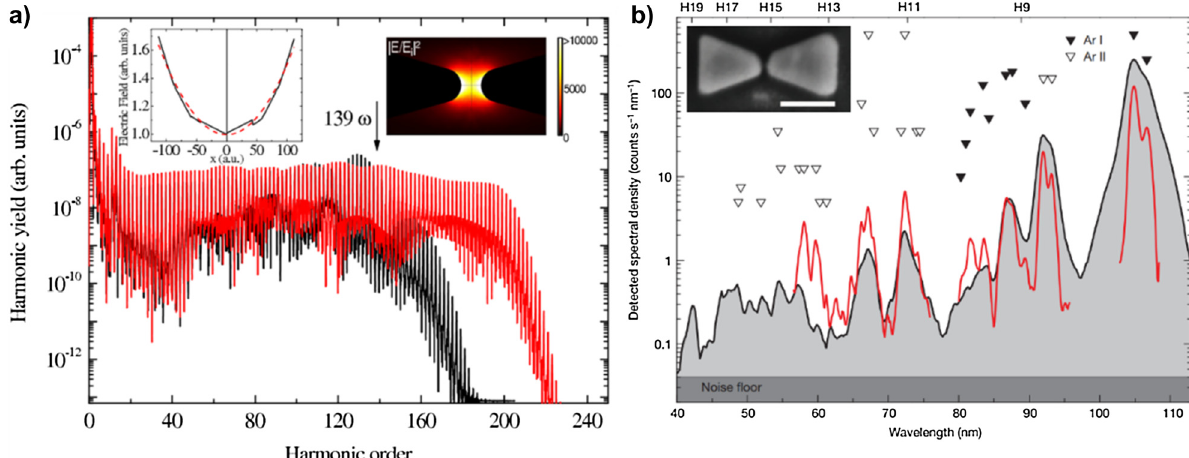
Figure 9: Numerical study and limitation of SP enhanced HHG in a gas. (a)NumericalsimulationoftheHHGspectrumfromanArgasatomlocatedatthecenterofthebowtienanostructurecalculatedviathe1DTDSE, (ionization potential E GS = − 15.7596 eV), at a peak intensity of I = 80 TW/cm 2 and a bowtie gap of 12 nm. High harmonic spectrum with a homogeneous electric fi eld (black) and a plasmonic-enhanced spatially inhomogeneous electric fi eld (red). Calculated electric fi eld distribution, E ( x , t ), at the bowtie gap (left inset), and intensity enhancement distribution at the bowtie structure (right inset) Adapted with permission from ref. [143]. Copyright 2012, OSA. (b) Atomic line emission spectrum from an Au bowtie structure array surrounded with Ar gas. The diffraction grating measured spectral density from the fi rst diffraction order (black line) and second diffraction order (red line). The Ar atomic line emission from the neutral ( fi lled triangle) and singly ionized Ar are indicated. The inset shows the SEM image of the Au bowtie structure with a 500 nm scale bar